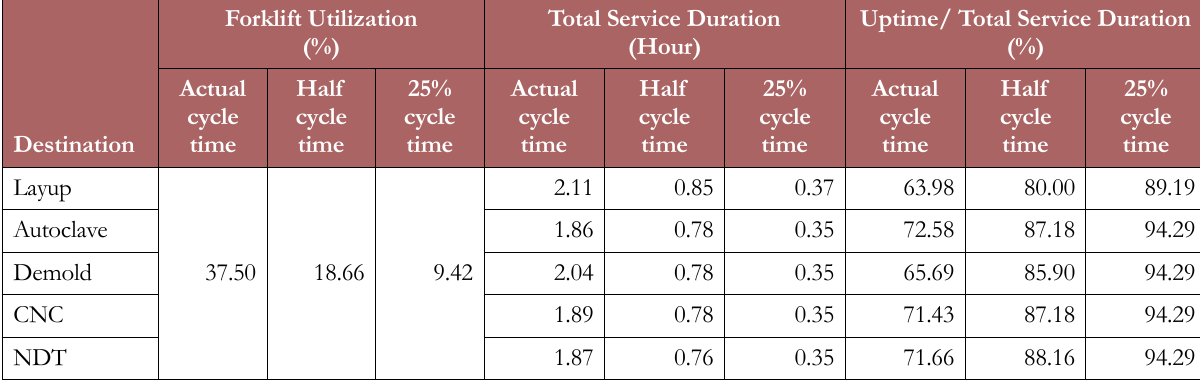
Table 5. Forklift utilization, total duration of transportation per product to all workstations, and uptime ratio in Experiment 1